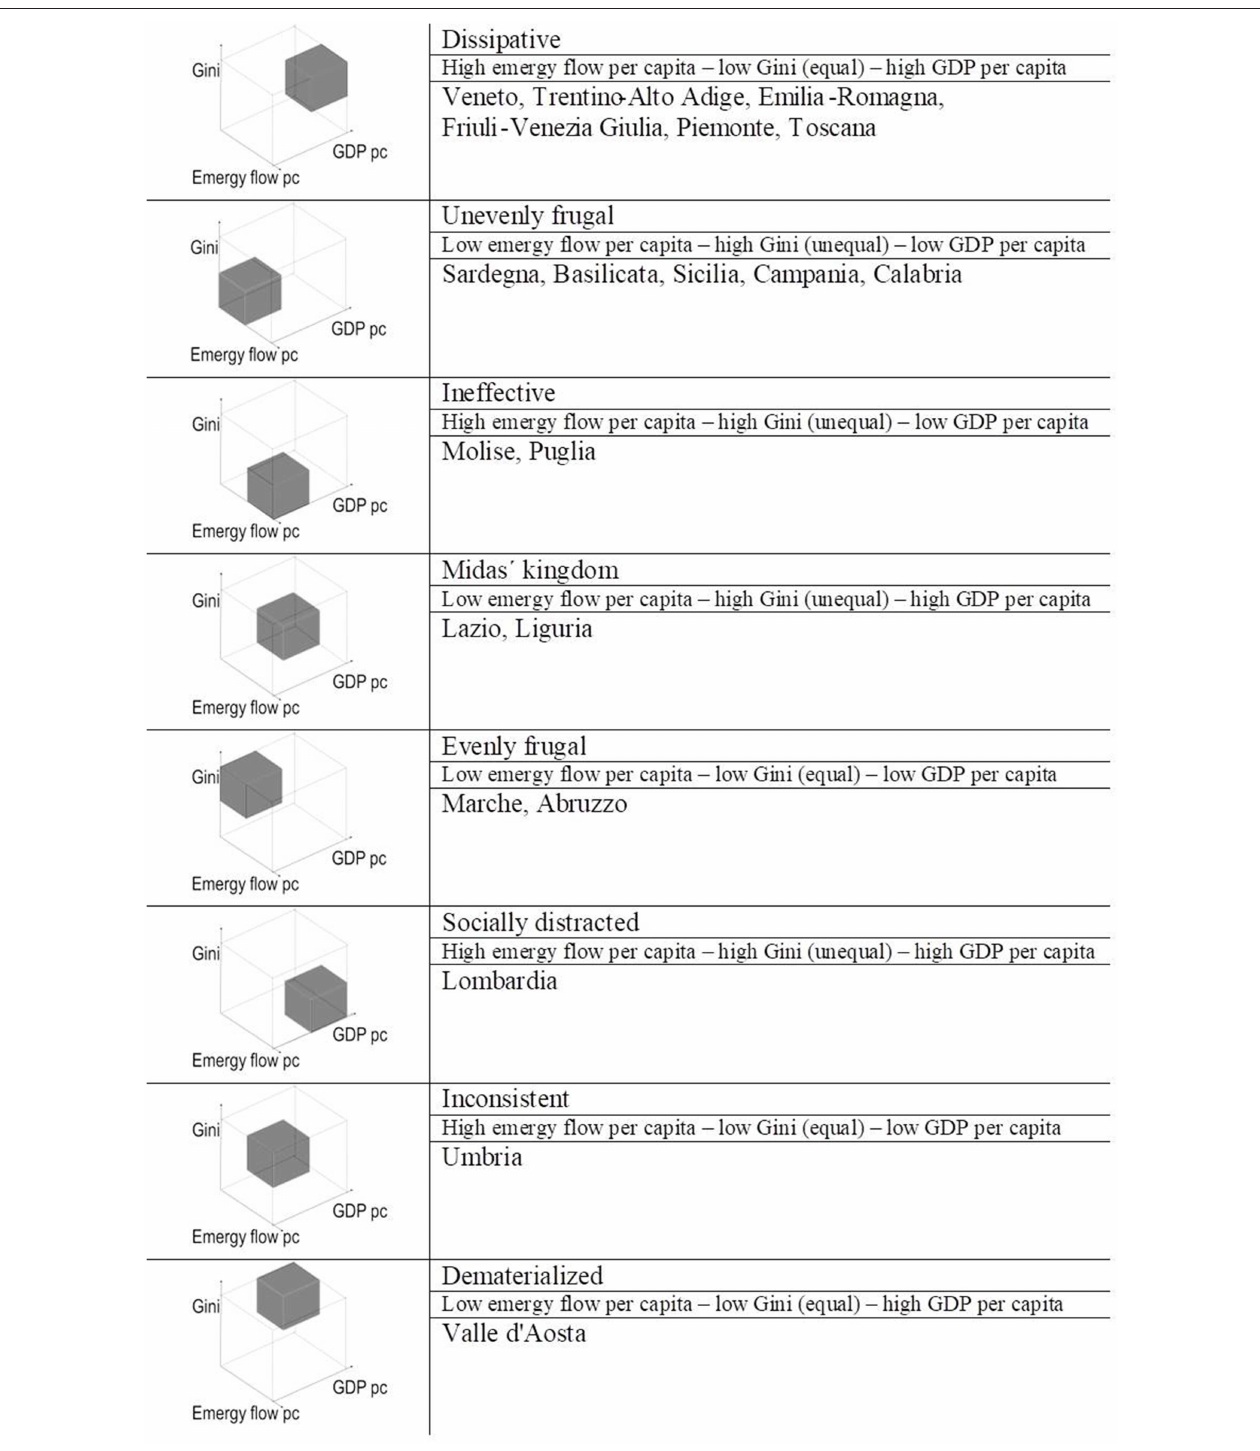
FIGURE 4 | The 8 sub-cubes within the 3D space and categorization of regions.